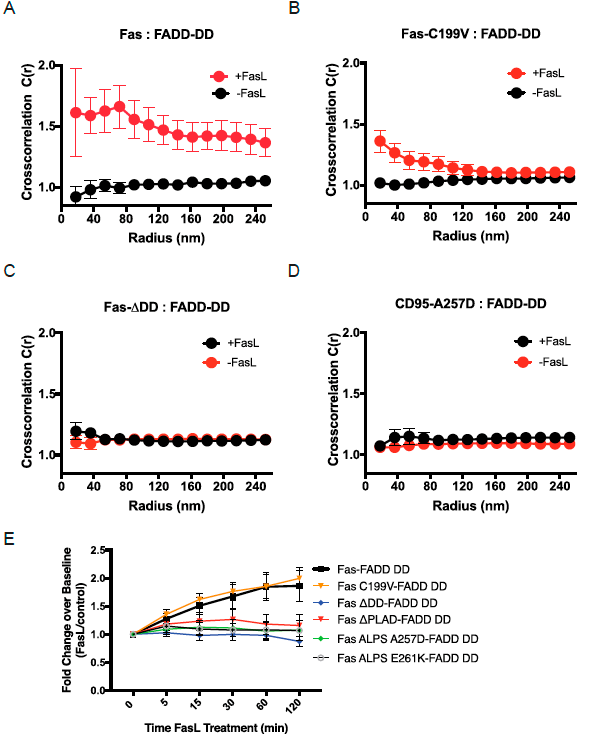
Figure 3. Cross-correlation and FRET analysis of Fas–FADD interactions. ( A – D ) Spatial interactions of FADD with either wild-type Fas or different mutants of Fas receptors on plasma membrane of Jurkat cells were quantified by spatial cross-correlation analysis of multicolor PALM images. PAGFP-tagged receptor molecules and FADD-PAmCh were coexpressed in Jurkat cells and imaged with or without interactions with FasL on DOPC-based fluid supported lipid bilayers. Plots of spatial cross-correlation ( c(r) ) between FADD-PAmCh and PAGFP-labeled wild-type Fas receptor ( A ), palmitoylation deficient Fas-C99V ( B ), Fas- Δ DD lacking death domain ( C ), or the ALPS mutant Fas-A257D ( D ). Value of c(r) >1 indicates increased spatial clustering of the two kinds of molecules, c(r) < 1 indicates spatial exclusion, and c(r) = 1 indicates random distribution of the molecules. ( E ) Fas-deficient RapoC2 Jurkat cells were cotransfected with a Cerulean3-tagged FADD containing only the death domain (FADD DD) and either wild-type or mutant Fas receptors as indicated. Cells were treated with FasL-LZ and changes in FRET between Fas and FADD were analyzed as in Figure 2E,F. A minimum of three independent experiments were performed ( n = 3).